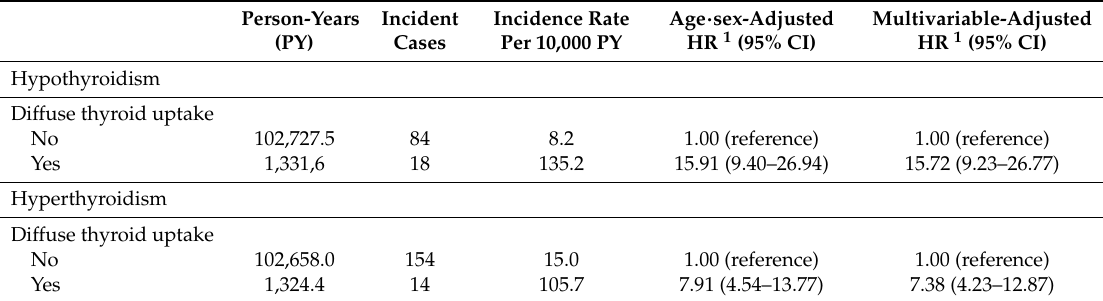
1 Estimated from parametric proportional hazard models. Multivariable model 1 was adjusted for age, sex, center, year of screening exam, smoking status, alcohol intake, physical activity, educational level, total calorie